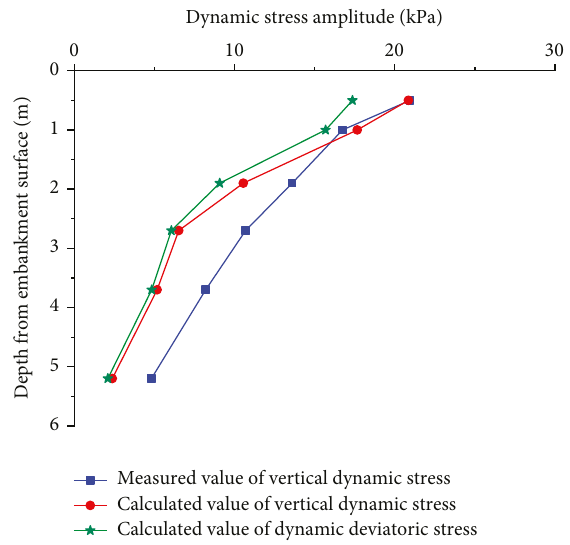
Figure 9: Dynamic stress amplitudes along depth